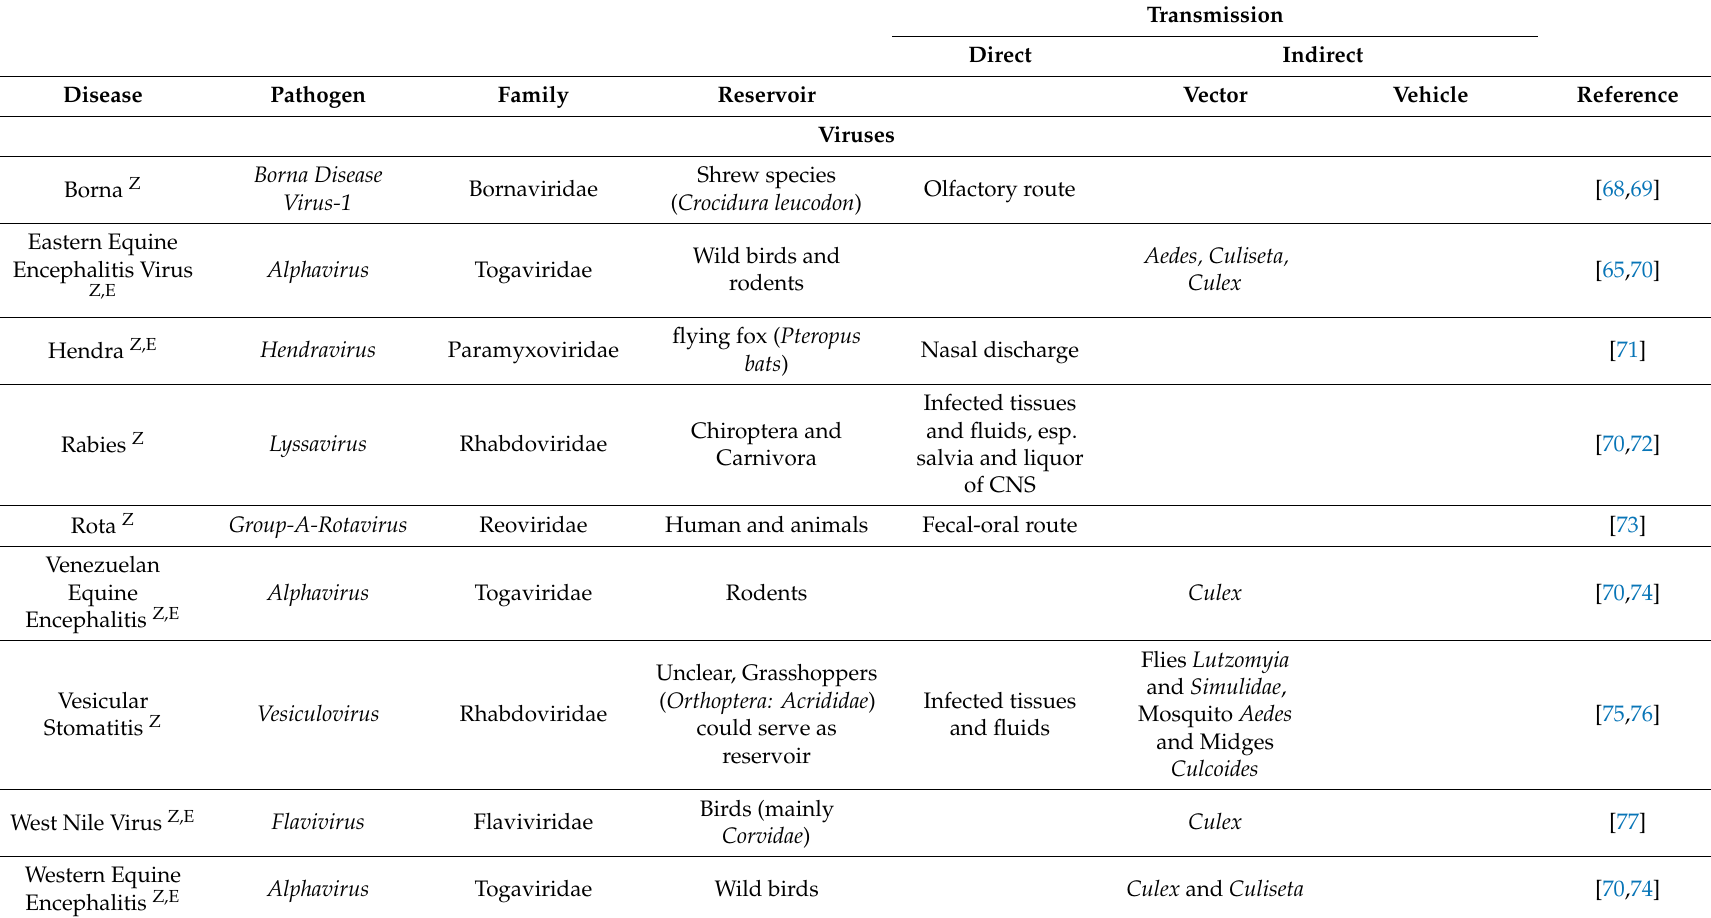
Table 1. Horse / human zoonotic and emerging diseases. Z is zoonotic and E is